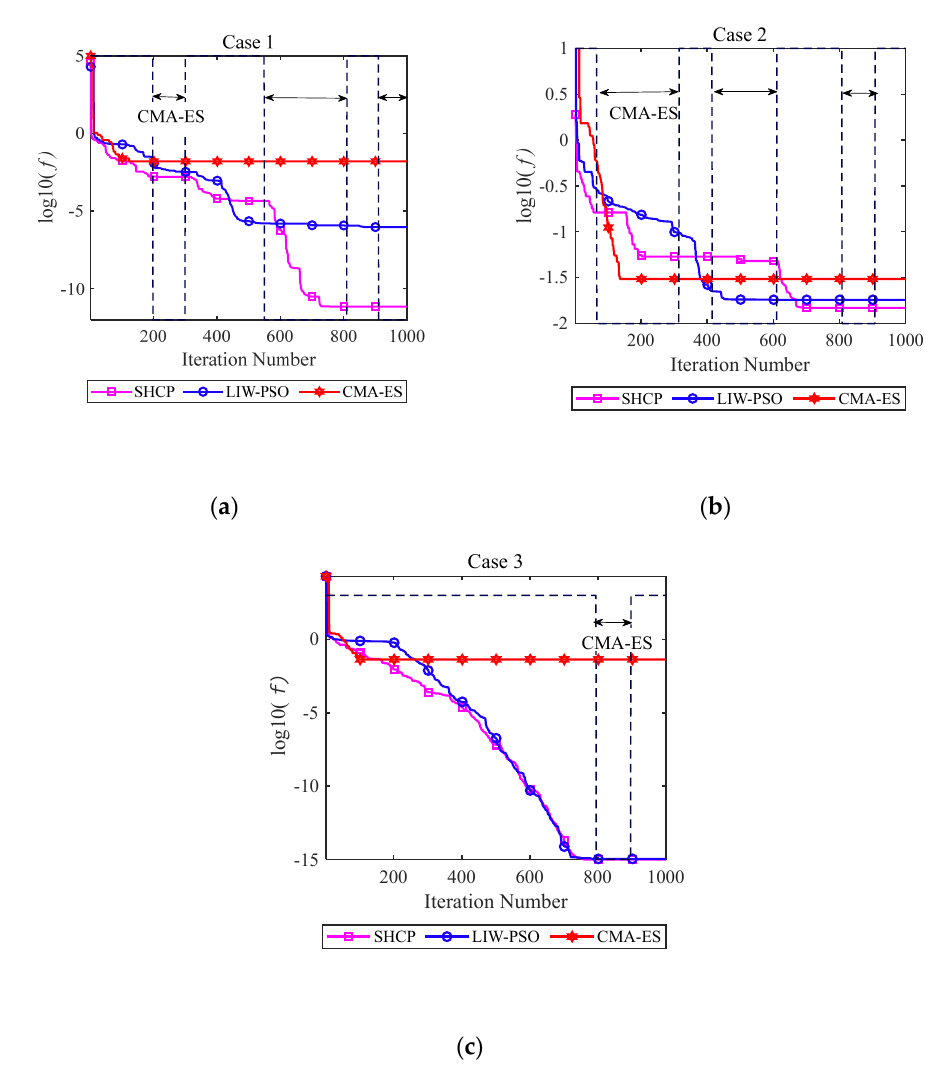
Figure 8. Segments and fitness curves of SHCP algorithm compared with original algorithms. ( a ) Case 1; ( b ) Case 2; ( c ) Case 3.